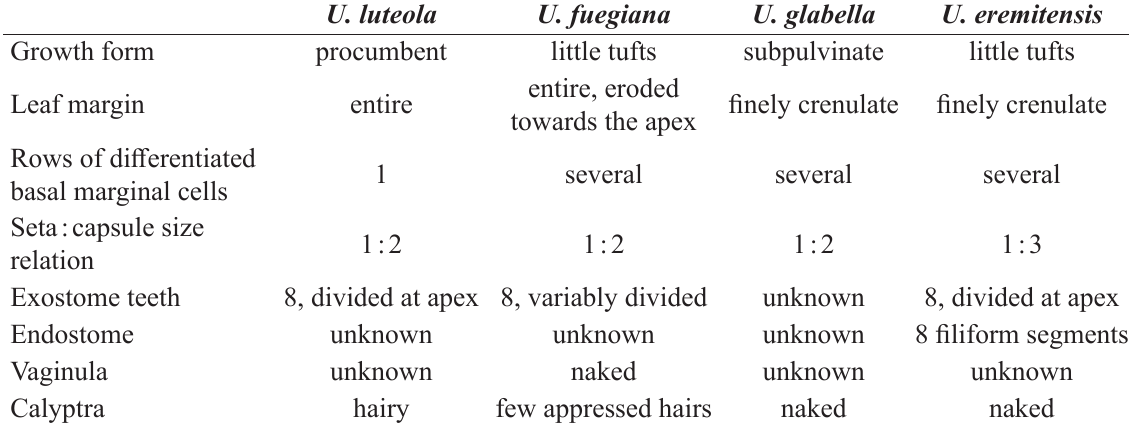
Table 1. Main differences between Ulota luteola (Hook.f. & Wilson) Wijk & Margad., U. fuegiana